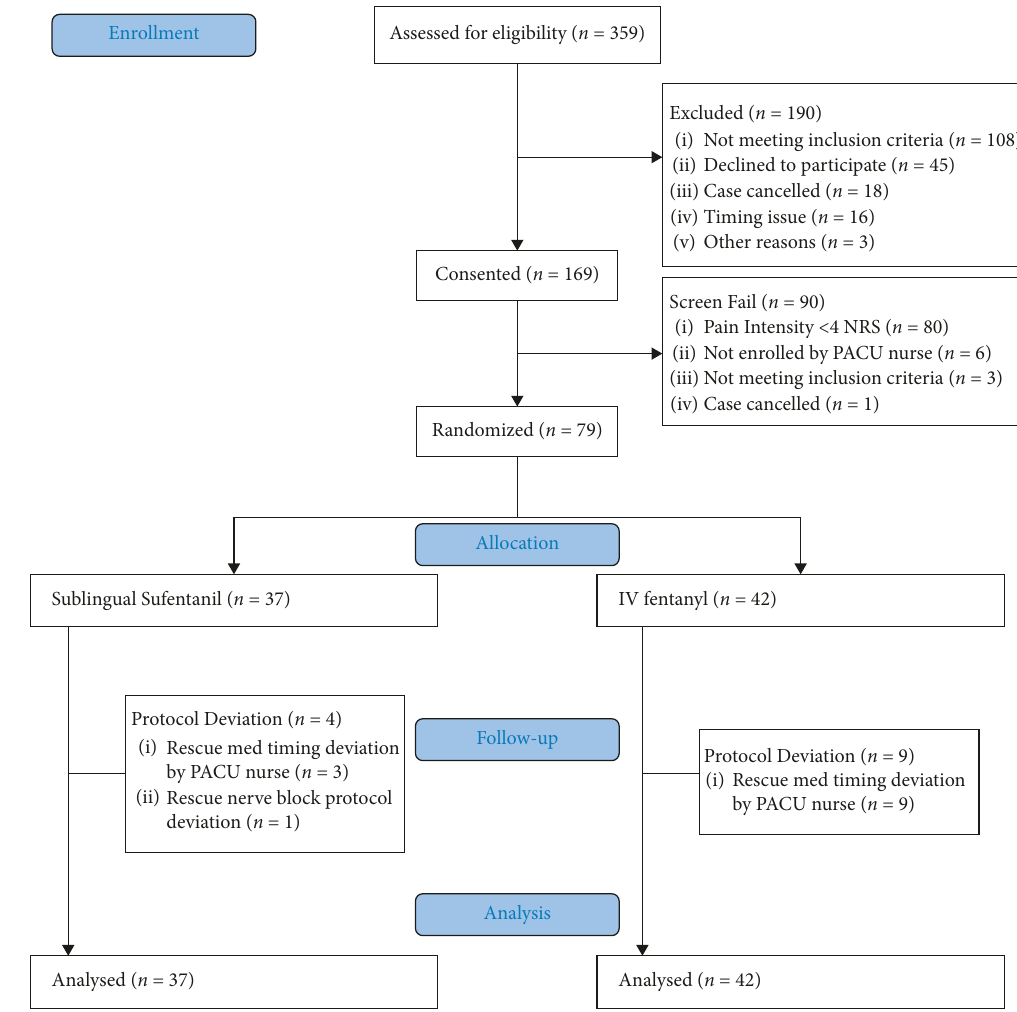
Figure 1: CONSORT diagram.